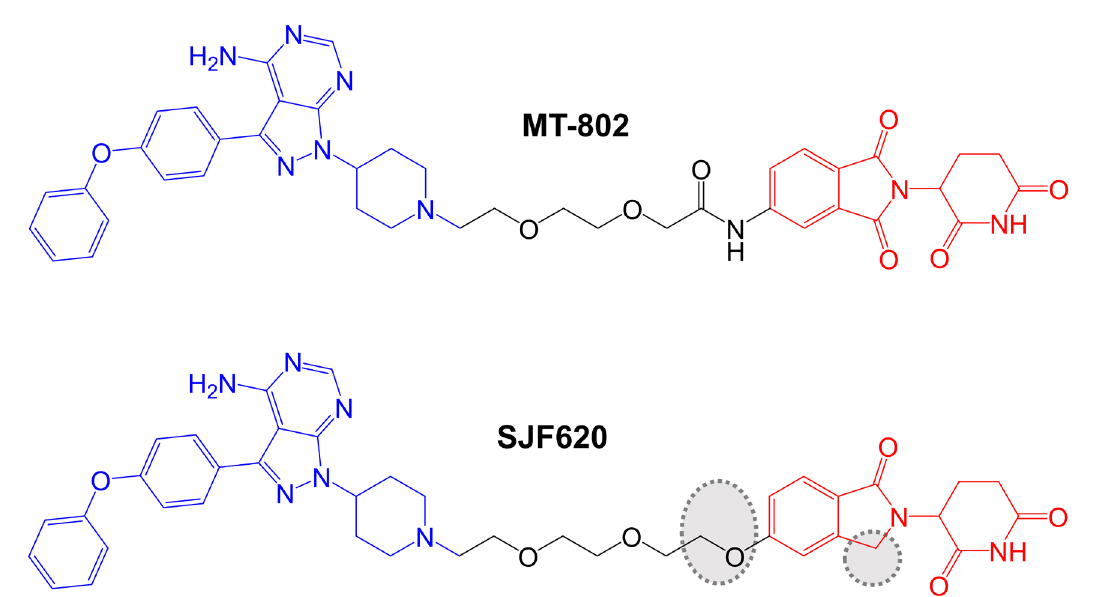
Figure 5. Structures of compounds MT-802 and SJF620. The reversible BTK-inhibiting warhead related to ibrutinib is colored blue and the CRBN-targeting moieties are colored red [ 87 , 88]. Differences in the structure of SJF620 compared to MT-802 are highlighted by dotted